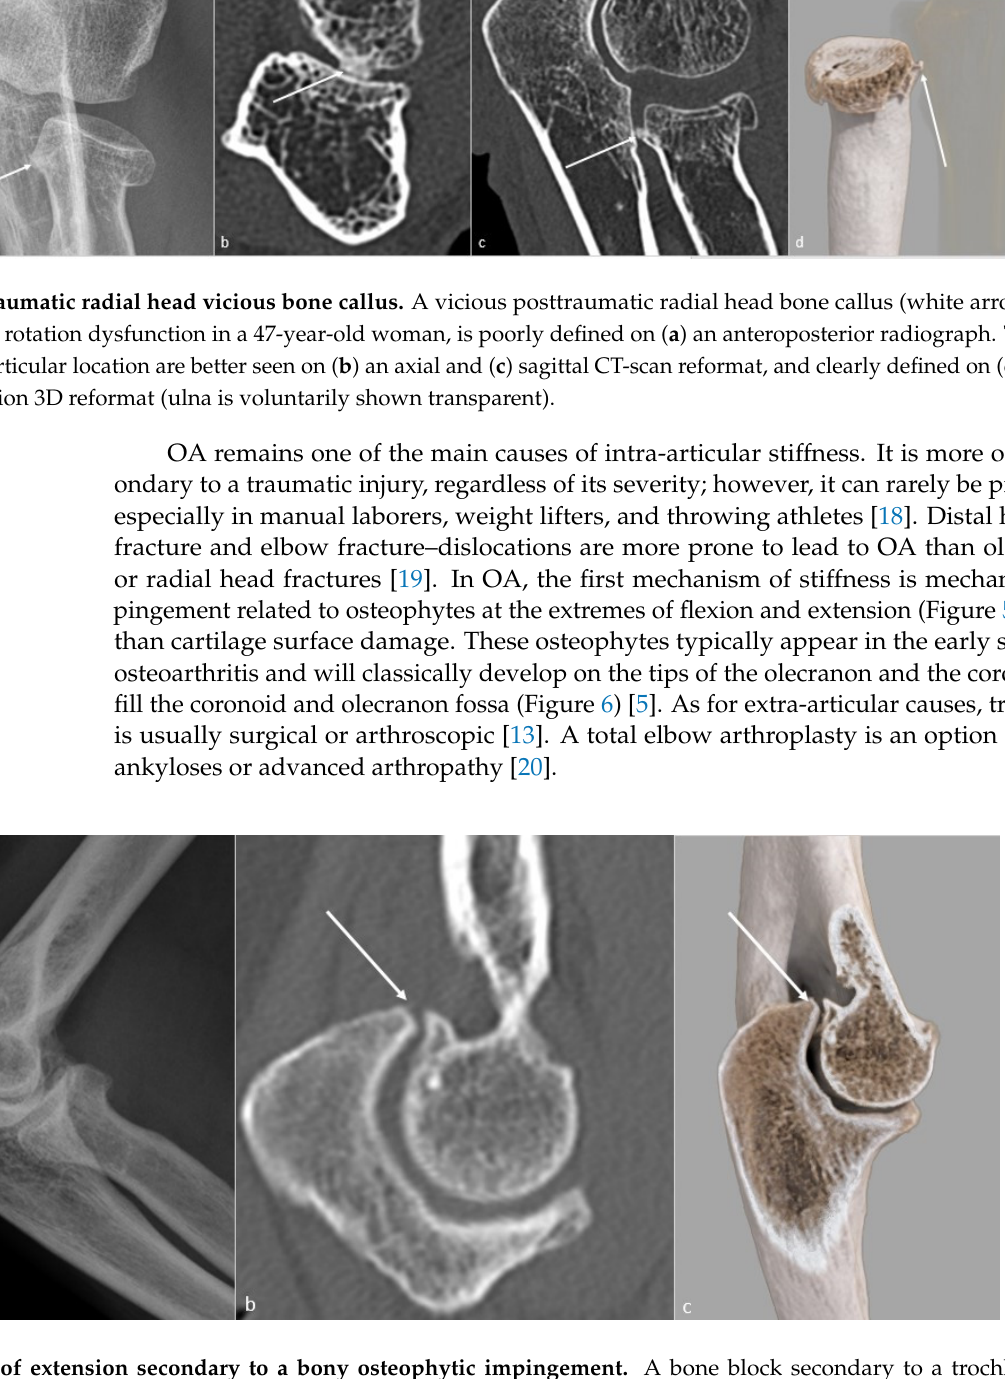
Figure 6. Olecranon fossa osteophytic filling. Osteophytic filling (white arrow) of the olecranon fossa (white dotted line) is shown on ( a ) a profile radiograph and ( b ) a sagittal CT-scan in a 26-year-old man who suffered from a humeral fracture and presents extension dysfunction when its corresponding normal aspect is shown in ( e , f ). The filling is also seen on ( c ) an extension global illumination 3D reformat and ( d ) in flexion (white arrows), when the normal aspect is shown in ( g , h ) (dotted white star).